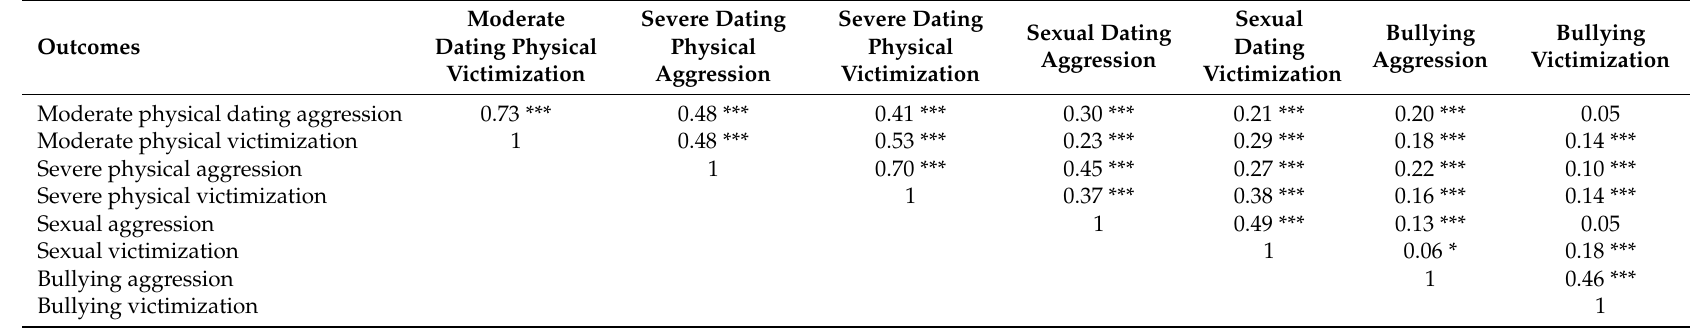
Table 3. Correlations among outcome